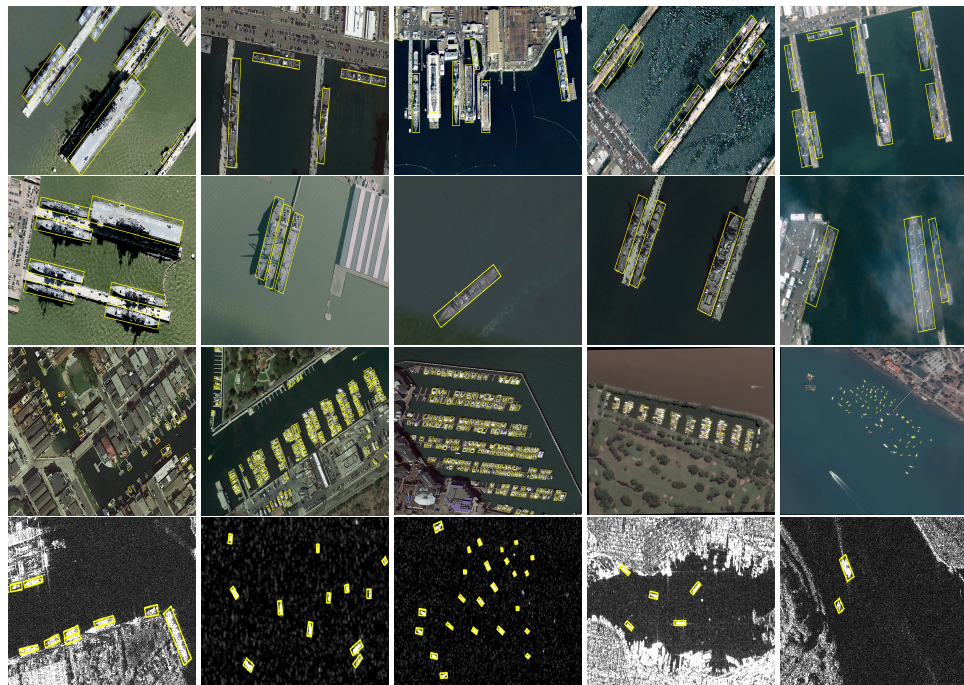
Figure 17. Some detection results on the test